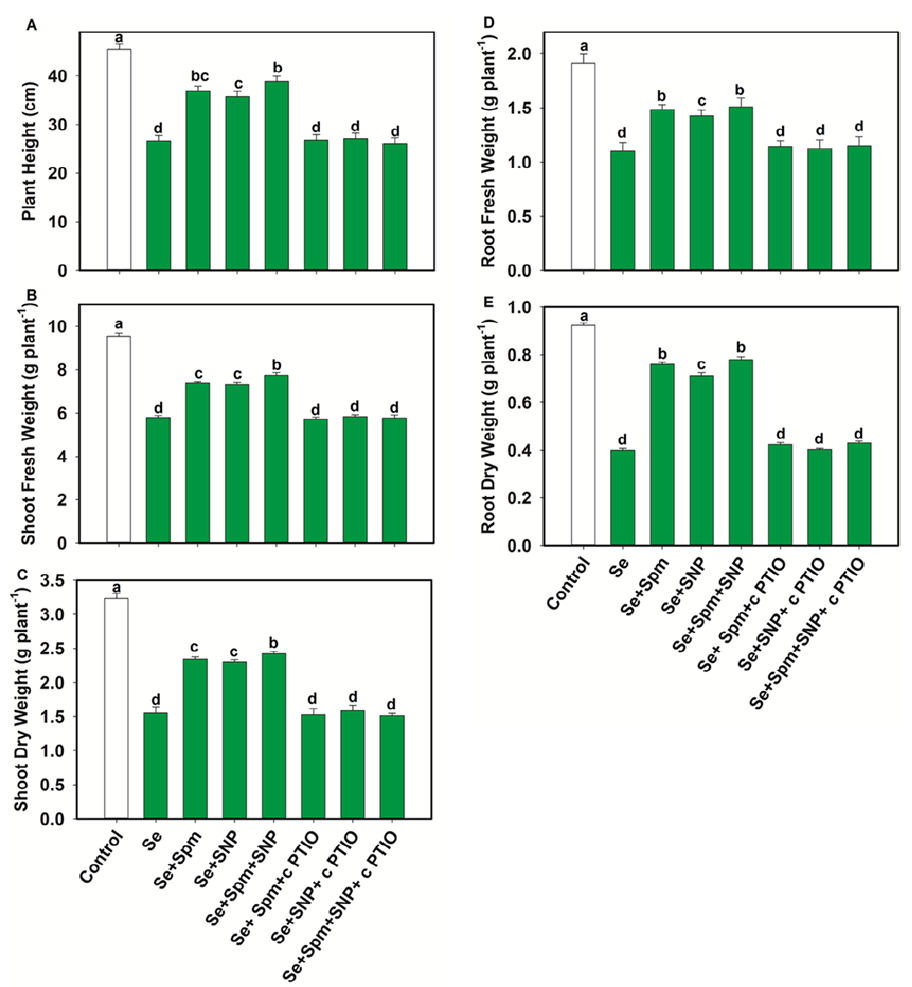
Figure 3. Plant height ( A ), shoot fresh weight ( B ), shoot dry weight ( C ), root fresh weight ( D ) and root dry weight ( E ) in leaves of 49-days-old-wheat plants grown under control and Se stress (1 mM) sprayed with 1.0 mM Spm or 0.1 mM SNP alone or together, combined with 0.1 mM cPTIO, a NO scavenger. Data presented are the mean (± SE) of three replicates, and bars with dissimilar letters (a–d) represent significantly different results at the p ≤ 0.05 level based on Fisher’s LSD test. Conversely, exogenous application of Spm markedly increased the PH by 27%, SFW by 21%, SDW by 34%, RFW by 26% and RDW by 47%. Moreover, the combination of Spm with NO (Se + SNP) increased these parameters by 26, 21, 33, 23 and 44%, respectively, compared with Se-stressed